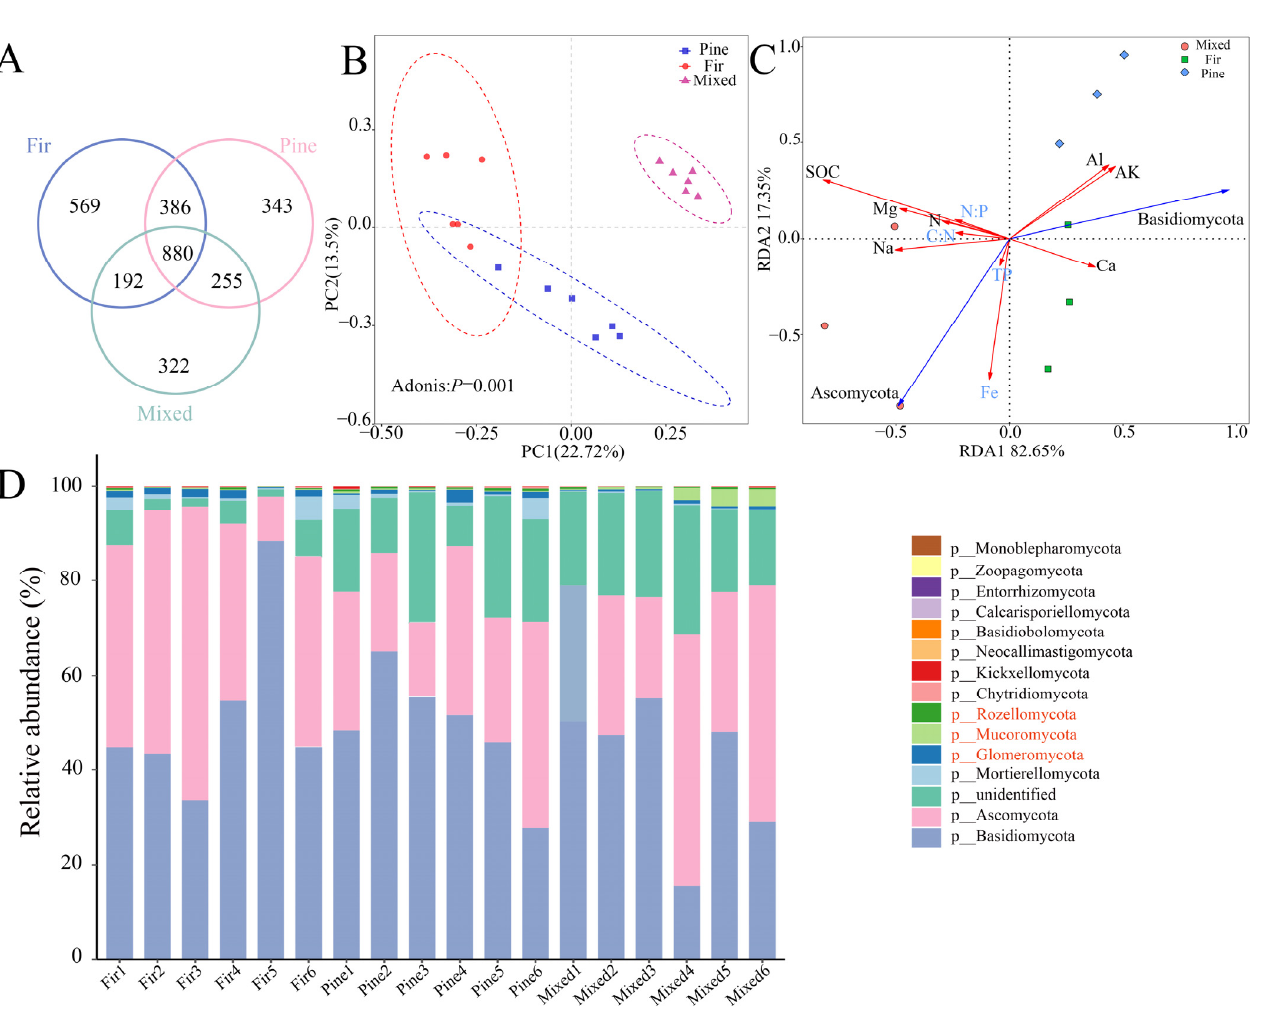
Values are means ± standard error and means followed by different letters in the same column significantly different at the 0.05 level. Fir: pure C. lanceolata forest; Pine: pure Pinus forest; Mixed: mixed forest of C. lanceolata